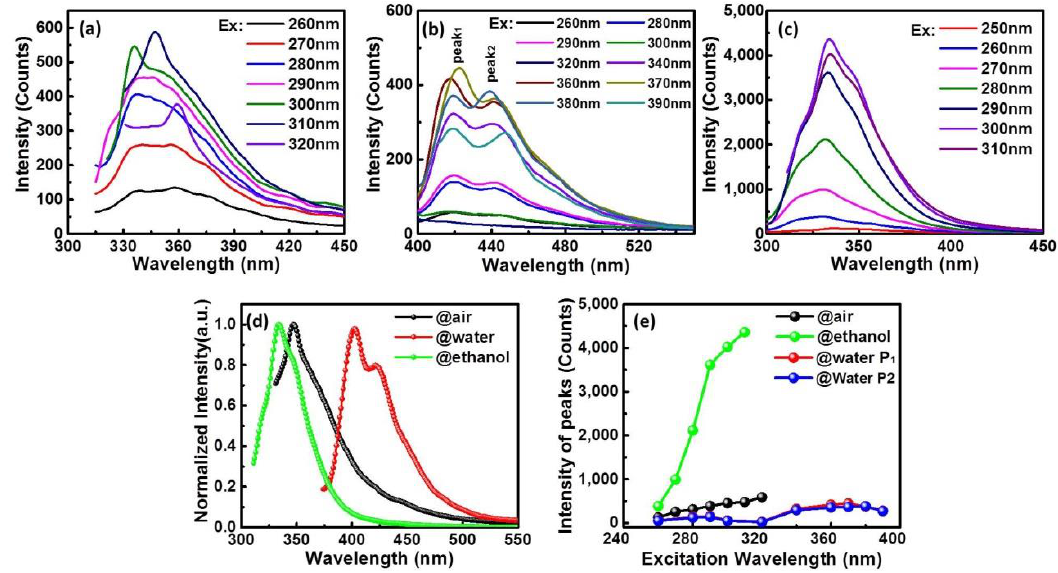
Figure 5. The photoluminescence (PL) spectra of ( a ) GaN-NPs@air, ( b ) GaN-NPs@water and ( c ) GaN-NPs@ethanol with different excitation wavelength; ( d ) the maximum PL emissions and ( e ) the emissions’ intensity of three kinds of GaN-NPs.